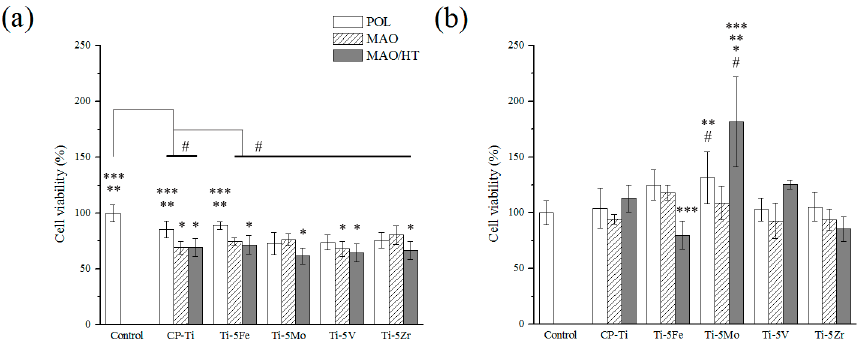
Figure 10. Cell viability measured by MTT assay on ( a ) the surfaces and in ( b ) the extraction lysate